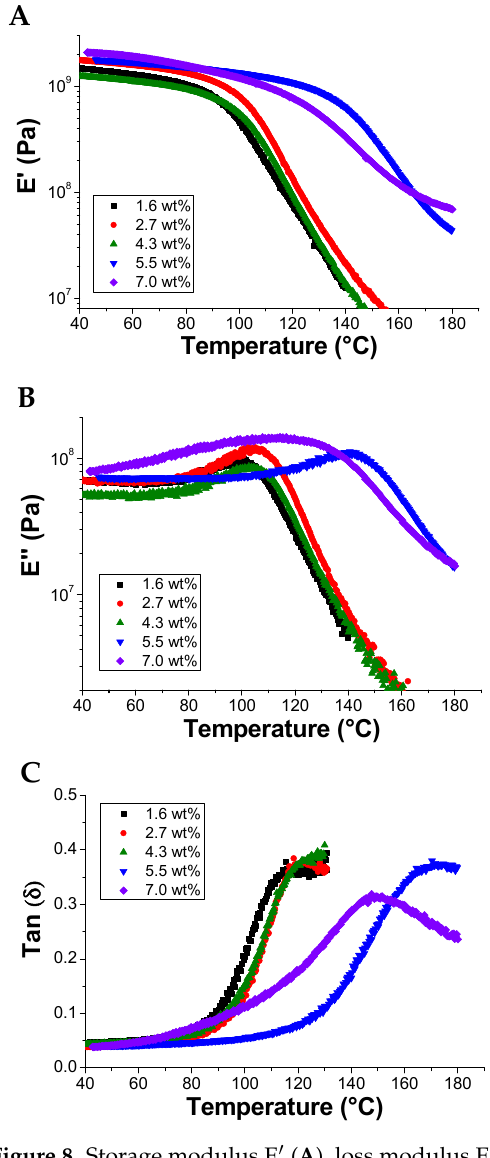
Figure 8. Storage modulus E ′ ( A ), loss modulus E ″ ( B ) and tan δ ( C ) of the rGO/PKFUBISM with different amounts of rGO as a function of the temperature.